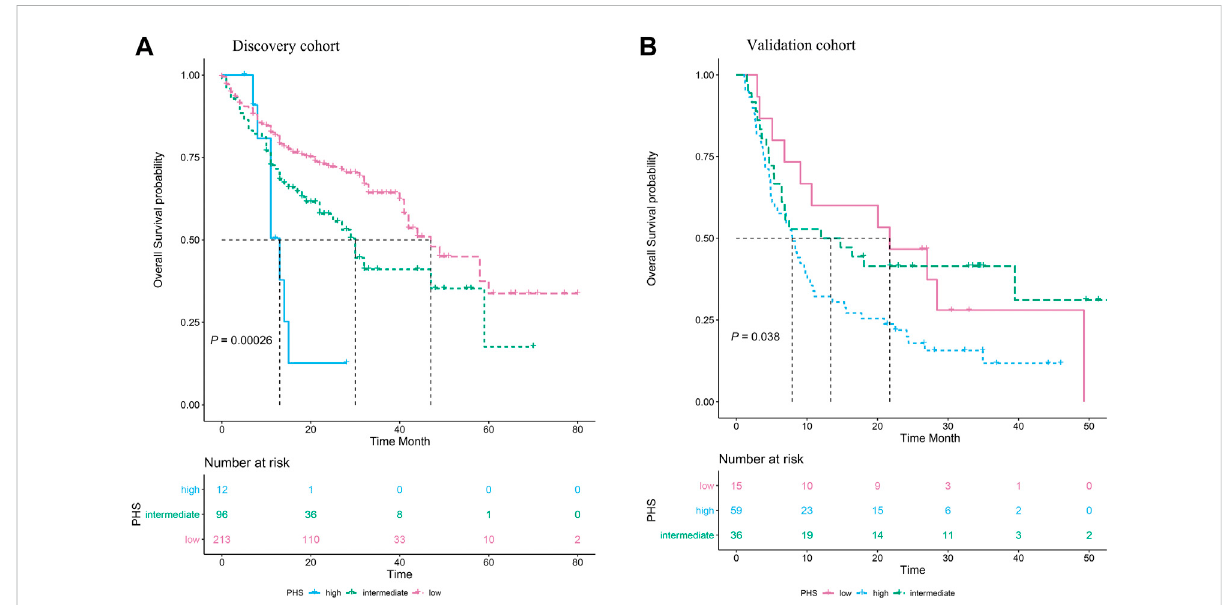
FIGURE 2 Theassociationofpolygenichazardratio(PHS)levelswiththeoverallsurvivalinmetastaticmelanomapatientstreatedwithimmunecheckpoint inhibitors in two independent datasets. (A) . Three subgroups, i.e., the high PHS, the intermediate PHS, and the low PHS, have signi fi cantly different overall survival rates in the MSK-IMPACT cohort. (B) The PHS model was successfully validated in the DFCI metastatic melanoma cohort, the group with high PHS had the poorest overall survival compared to the groups with intermediate PHS and low